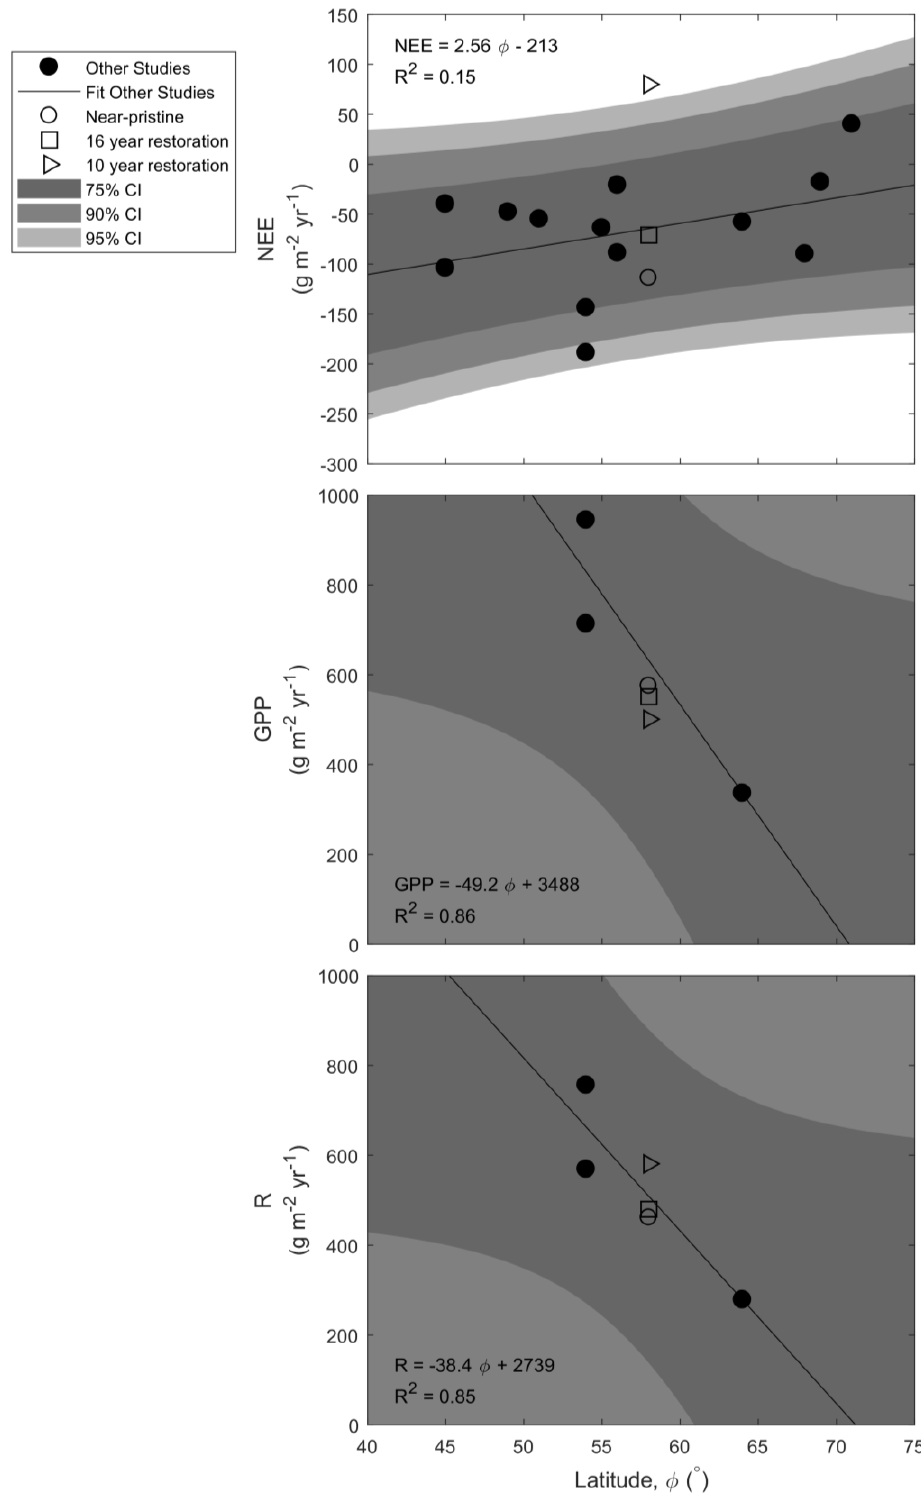
Figure 4. Annual NEE, GPP and R at “intact” peatland sites in the Northern hemisphere (black dots) (Oechel et al. 2000, Aurela et al. 2002, Friborg et al. 2003, Sottocornola & Kiely 2005, Syed et al. 2006, Lund et al. 2007, Roulet et al. 2007, Flanagan & Syed 2011, Christensen et al. 2012, Strilesky & Humphreys 2012, Peichl et al. 2014, Helfter et al. 2015, Levy & Gray 2015, Pelletier et al. 2015). Fluxes expressed as CO C. Linear fits are shown based on these natural peatland sites (black line). Based on the linear fits 95 %, 90 % and 75 % confidence intervals (CI) for new observations are predicted (shaded areas). The open symbols show the annual estimates for NEE, GPP and R from the near-pristine, 16-year restoration and 10- year restoration sites from this study. Note that these three sites were not used in the curve